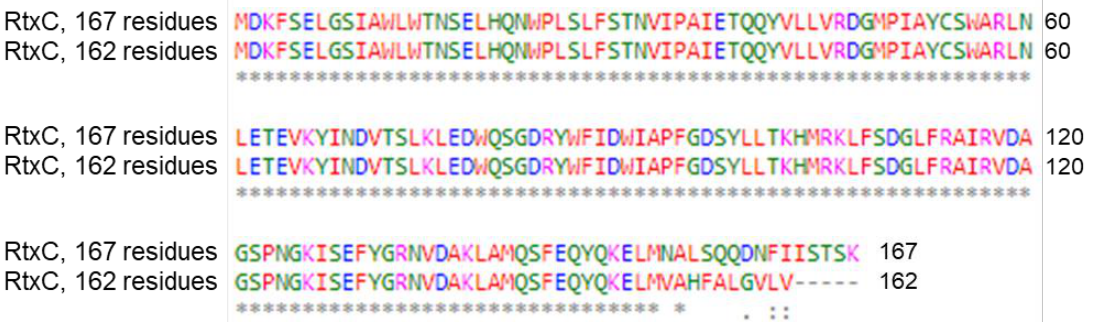
Figure 4. The ClustalW sequence alignment of two RtxC variants of K. kingae strain ATCC 23331. Symbols: (*) identity; (:) strongly similar; (.) weakly similar.